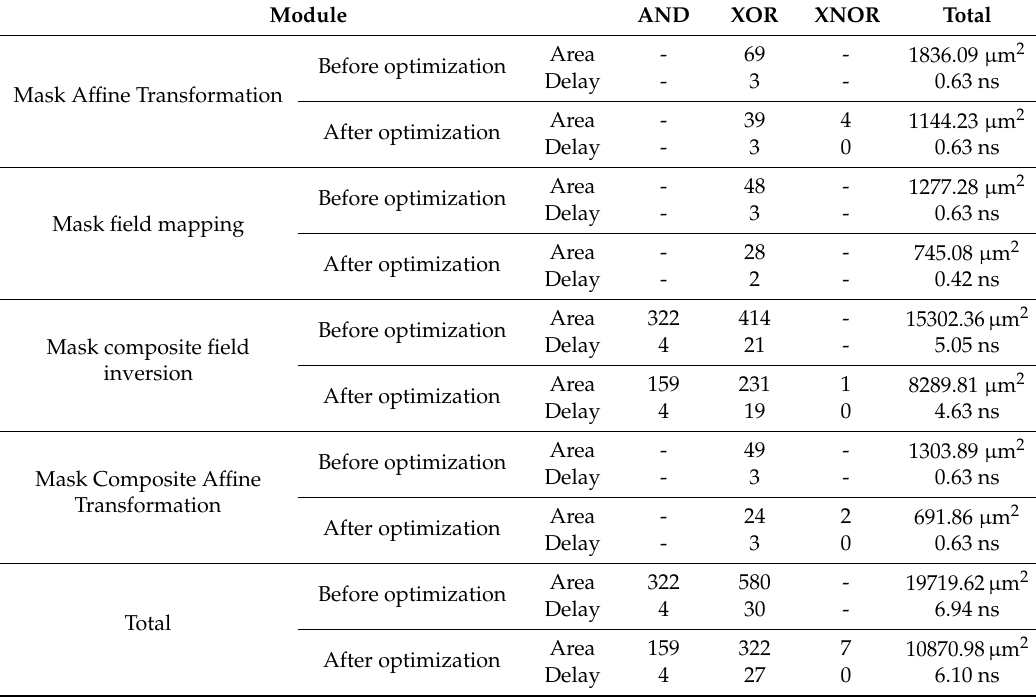
Table 2. Comparison of the area and delay of each module before and after the mask S-box